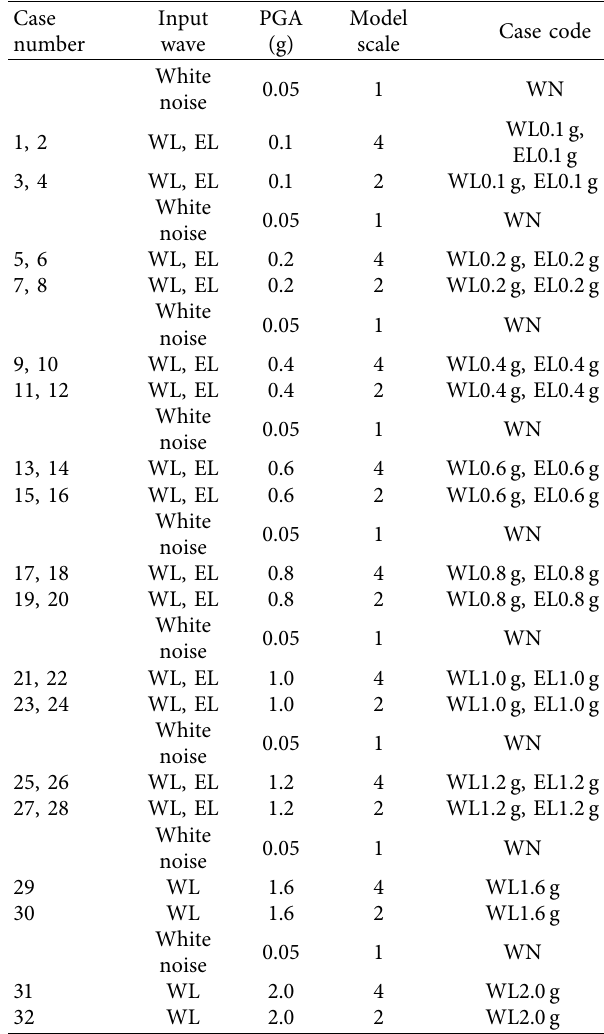
Table 3: Loading cases of specimen 1. Table 4: Loading cases of specimen